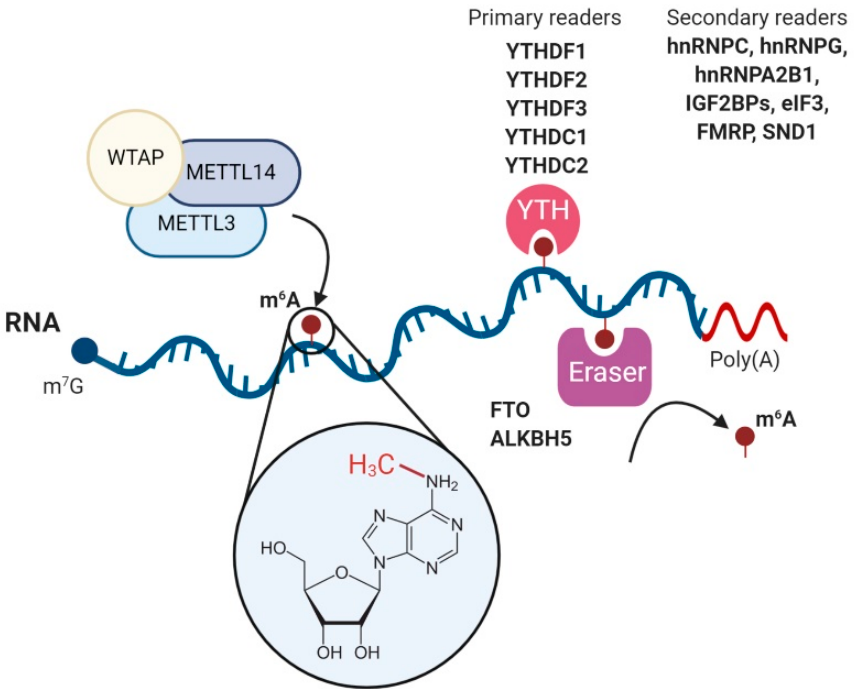
Figure 1. The m 6 A RNA modification and its cellular interactome. The N 6 -methyladenosine (m 6 A) modification is installed co-transcriptionally to mRNA transcripts by the METTL3-METTL14-WTAP writer complex and can be removed by the FTO and ALKBH5 erasers. The family of YTH proteins comprises the major readers that specifically recognise and directly bind m 6 A modifications. YTHDC1 is a nuclear m 6 A reader and facilitates mRNA splicing and nuclear export. In the cytoplasm, YTHDF1, YTHDF2, YTHDF3 and YTHDC2 bind mRNAs to enhance their translation or induce their degradation in P-bodies. Other multiple secondary readers that also target m 6 A modifications have been recently elucidated. Some of these bind to m 6 A through structural RNA switches in the mRNA transcript induced by m 6 A itself.